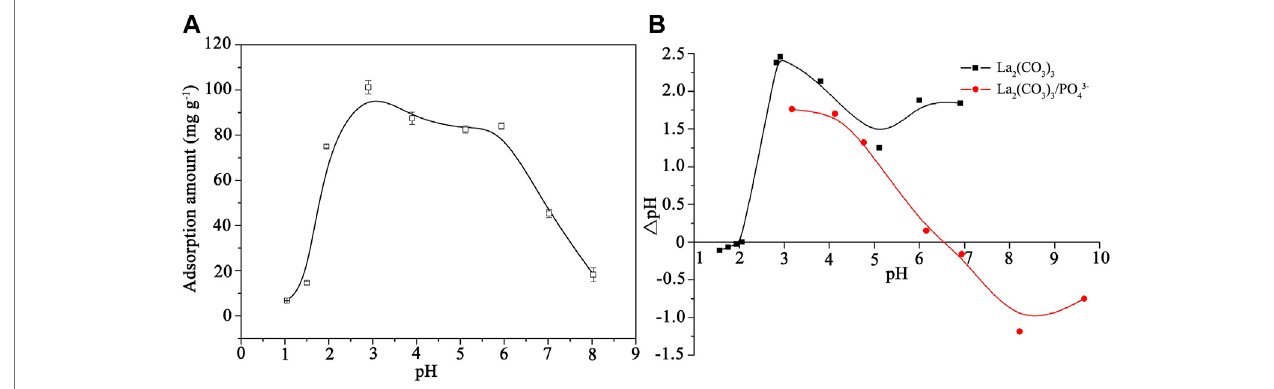
FIGURE 3 | Effect of solution pH on the adsorption of PO 43 − on La 2 (CO 3 ) 3 (A) . Zero-point charge (pH zpc ) of La 2 (CO 3 ) 3 and La 2 (CO 3 ) 3 /PO 43 − (B)